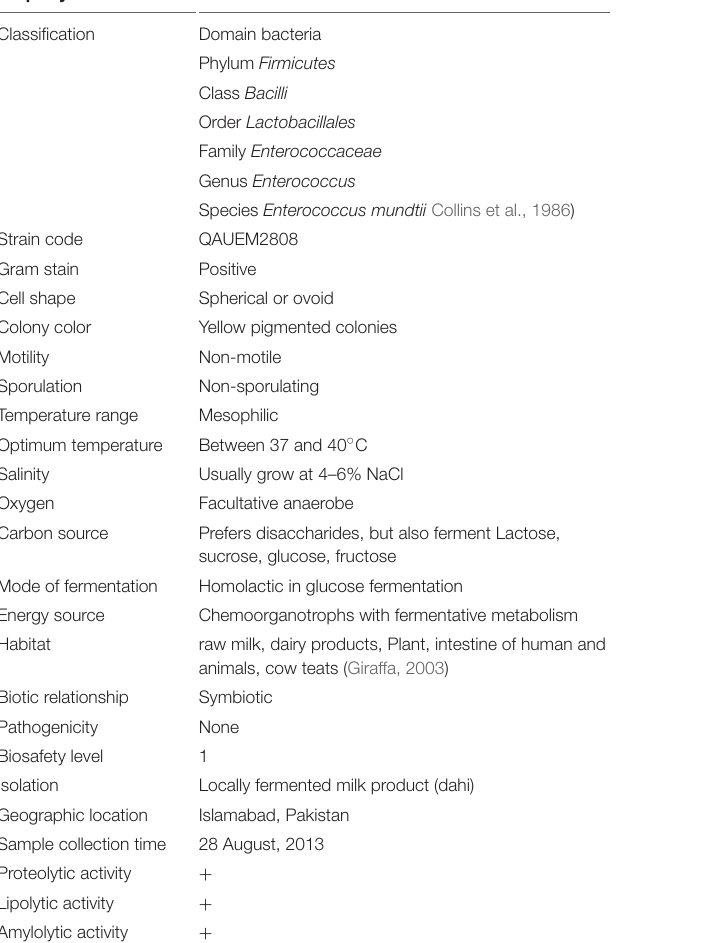
TABLE 1 | Classification and features of Enterococcus mundtii